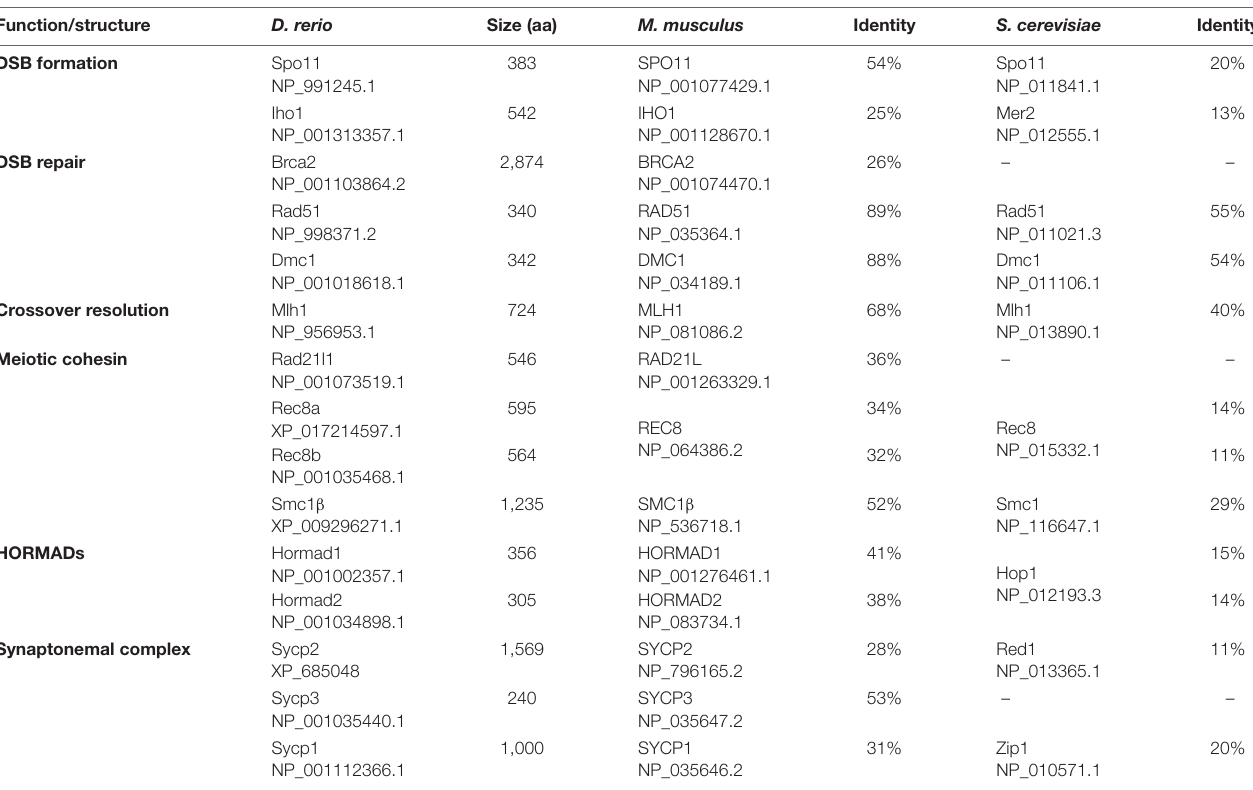
TABLE 1 | Conservation of amino acid sequence of meiosis proteins in zebrafish.